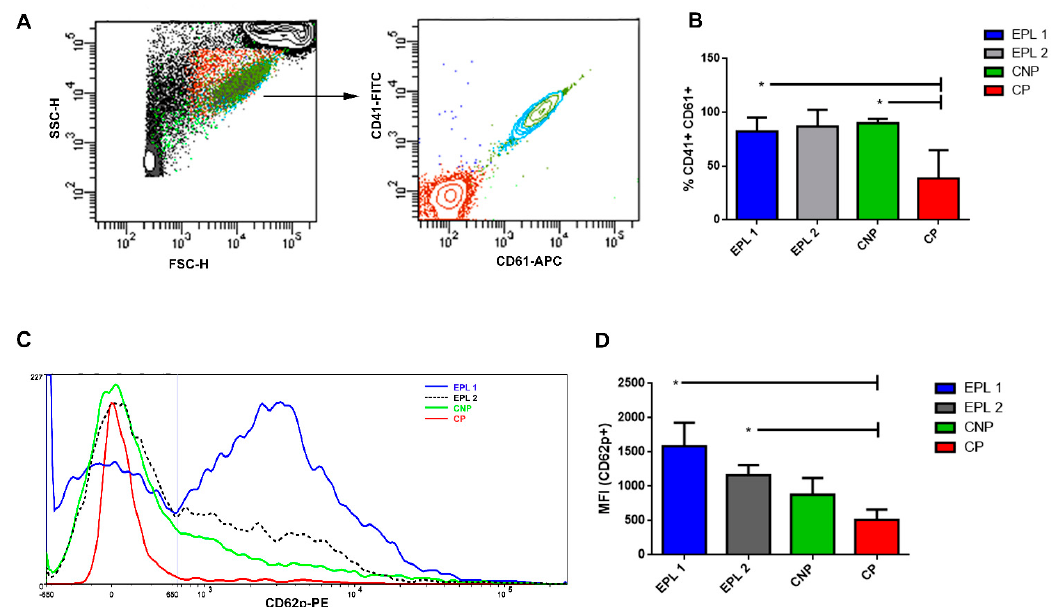
Figure 3. Expression of major platelet glycoprotein (CD41/CD61) and platelet activation marker CD62p. Gating strategy ( A ), percentages of platelets in the studied groups ( B ), representative fluorescence intensity ( C ) and cell count histograms ( D ) showing changes in the platelet expression of CD62p are shown; T-test * p ≤ 0.05.